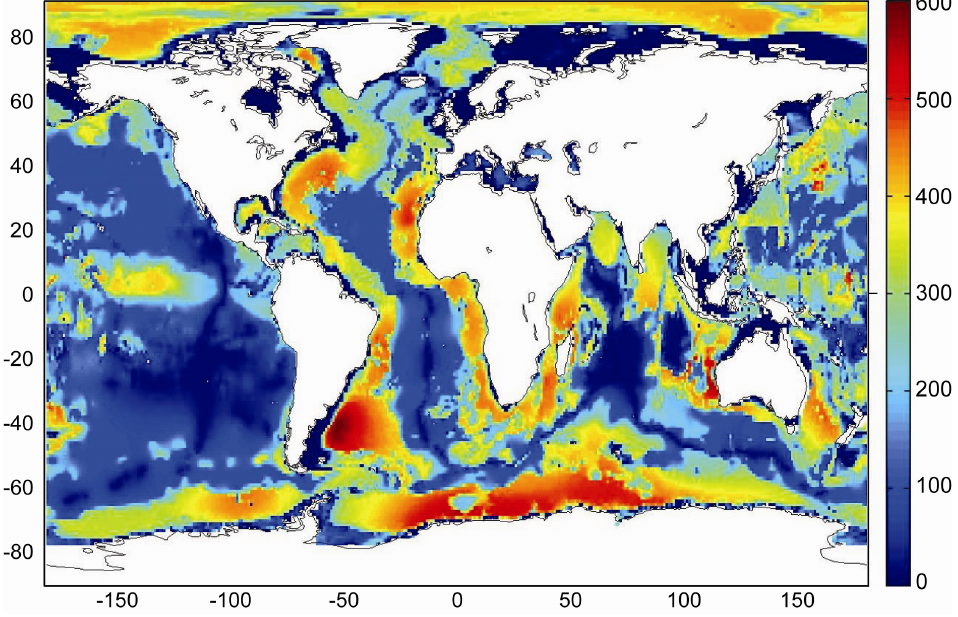
Figure 9. Thickness of the gas hydrate stability zone calculated from global heat flux data [43] considering bathymetry, bottom water temperature, sediment thickness data and a bulk thermal conductivity of 1.0 W m − 1 K − 1